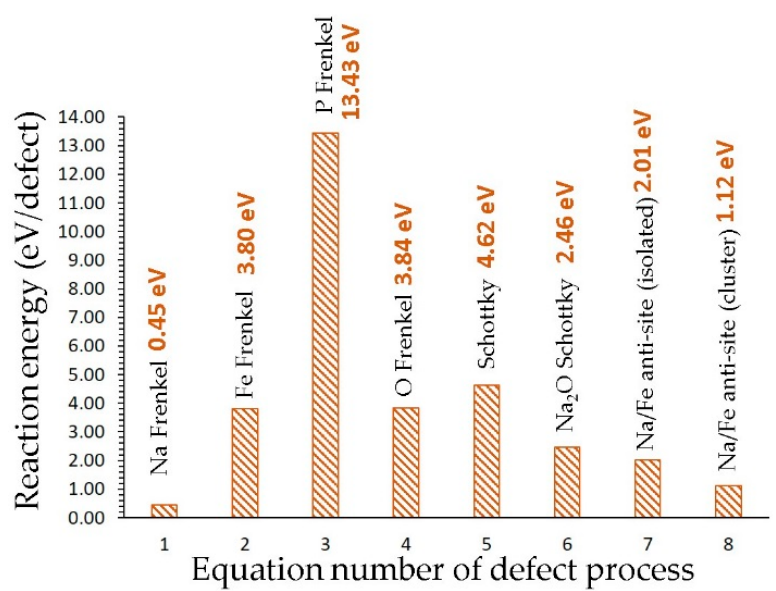
Figure 2. Energetics of intrinsic defect processes.